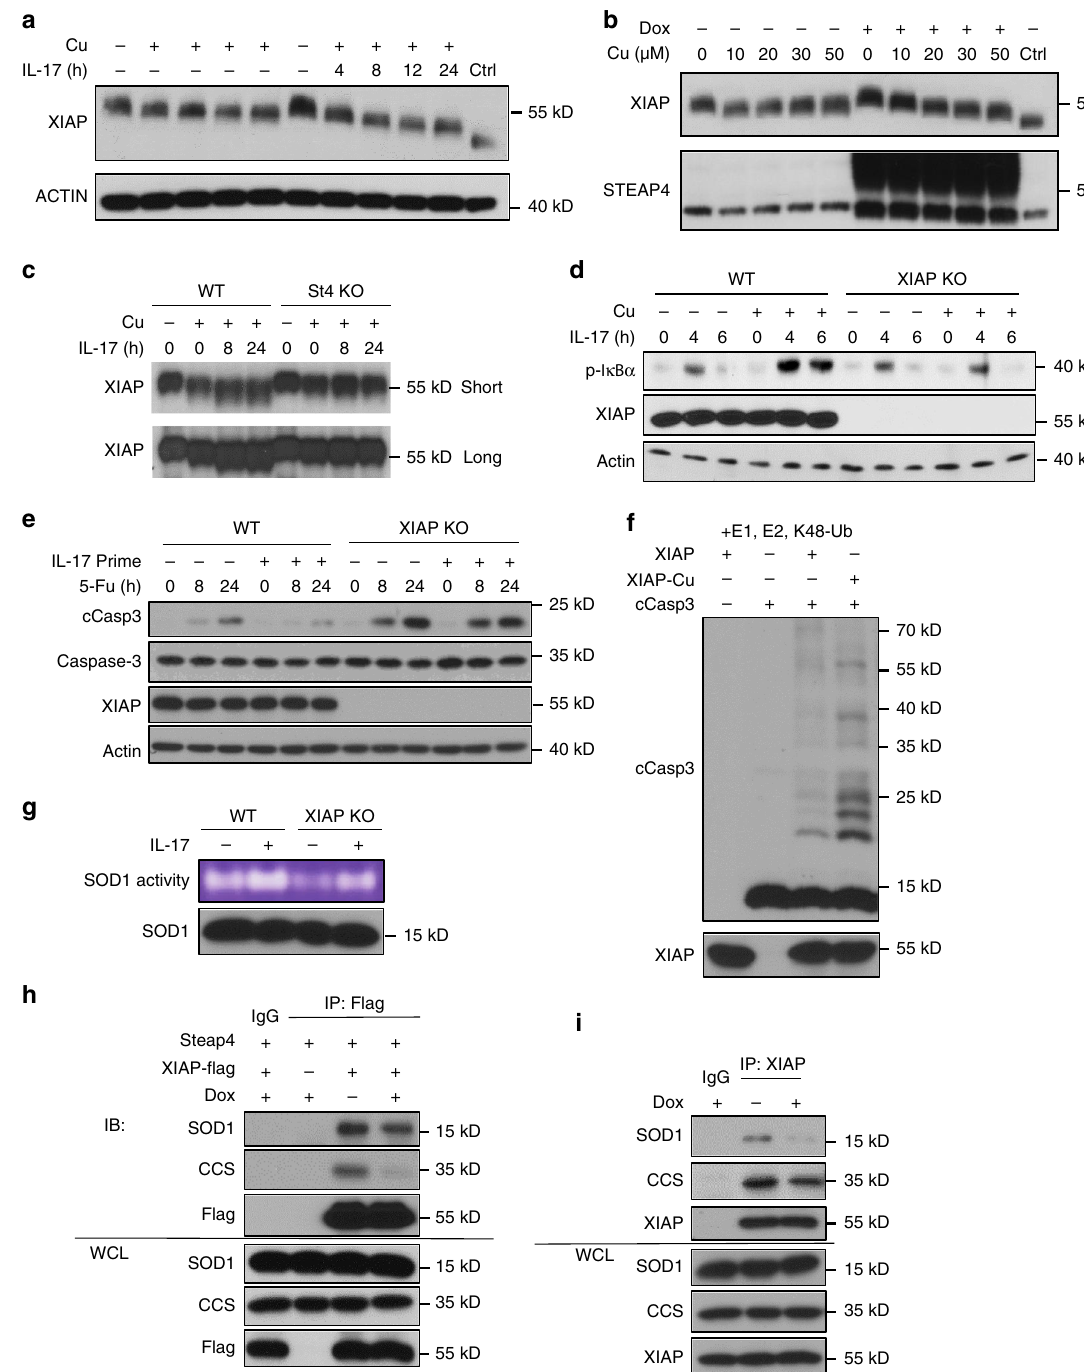
Fig. 4 IL-17-induced STEAP4-mediated copper uptake enhances the E3-ligase activity of XIAP. a IL-17 stimulation accentuates copper-induced XIAP shift. LS174T cells were pretreated with 10 µ M Cu(II) for 24 h and then IL-17 was treated at the indicated time points. b STEAP4 overexpression accentuates XIAP shift. STEAP4 was induced by 1 μ g/mL doxycycline for 24 h in the inducible clone and then treated with indicated concentrations of Cu (II) for 16 h. c STEAP4 is required for IL-17-induced accentuation of XIAP shift. Wild-type (WT) and STEAP4 knockout (St4 KO) intestinal organoids were fi rst exposed to 10 μ M Cu(II) for 16 h and then treated with IL-17 for indicated time points. d Western blots analysis for XIAP sustaining NF- κ signaling. XIAP WT and KO cells were pretreated with or without 10 μ M copper, followed by IL-17 treatment for the indicated time points. e XIAP inhibits Caspase-3 cleavage. XIAP WT and KO cell line were fi rst primed with IL-17 for 12 h and then treated with 5-FU for the indicated time points. f In vitro ubiquitination assay using recombinant XIAP prepared in the presence (XIAP-Cu) or absence (XIAP) of copper and cleaved human caspase-3 as substrate. g In-gel SOD activity assay in wild-type and XIAP knockout Ls174t in response to IL-17 stimulation. h Coimmunoprecipitation analysis of XIAP interaction with indicated protein in response to STEAP4 expression in STEAP4-inducible clone. i Coimmunoprecipitation analysis of endogenous XIAP in response to STEAP4 expression. Data represent three independent experiments with similar